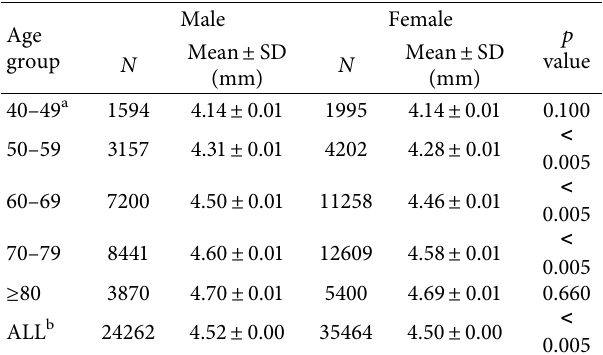
Figure 1: Histogram showing the distribution of lens thickness in Chinese cataract patients. Table 1: Lens thickness in Chinese cataract patients, stratified by gender and